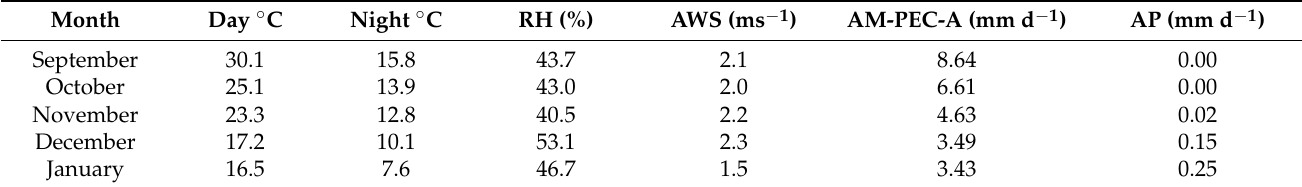
Table 1. Average weather data for the Fayoum region in Egypt during the carrot growing seasons. Month